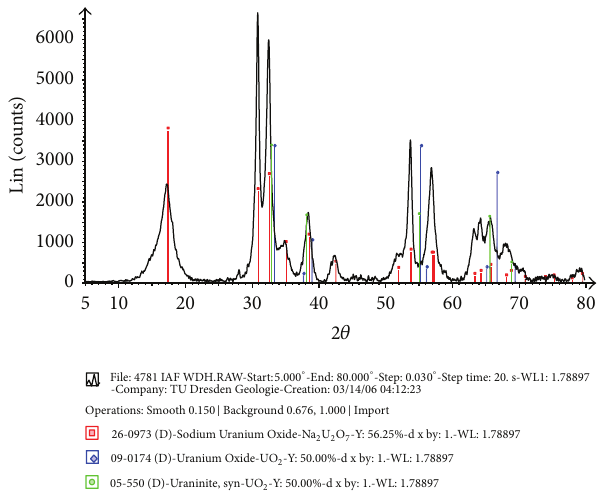
Figure 3: X-ray diffraction patterns of the uranium precipitate that show only the reflections of Na 2 U 2 O 7 and excluded other uranium species to be present. This X-ray diffractogram was performed by TU Dresden/Geologie.